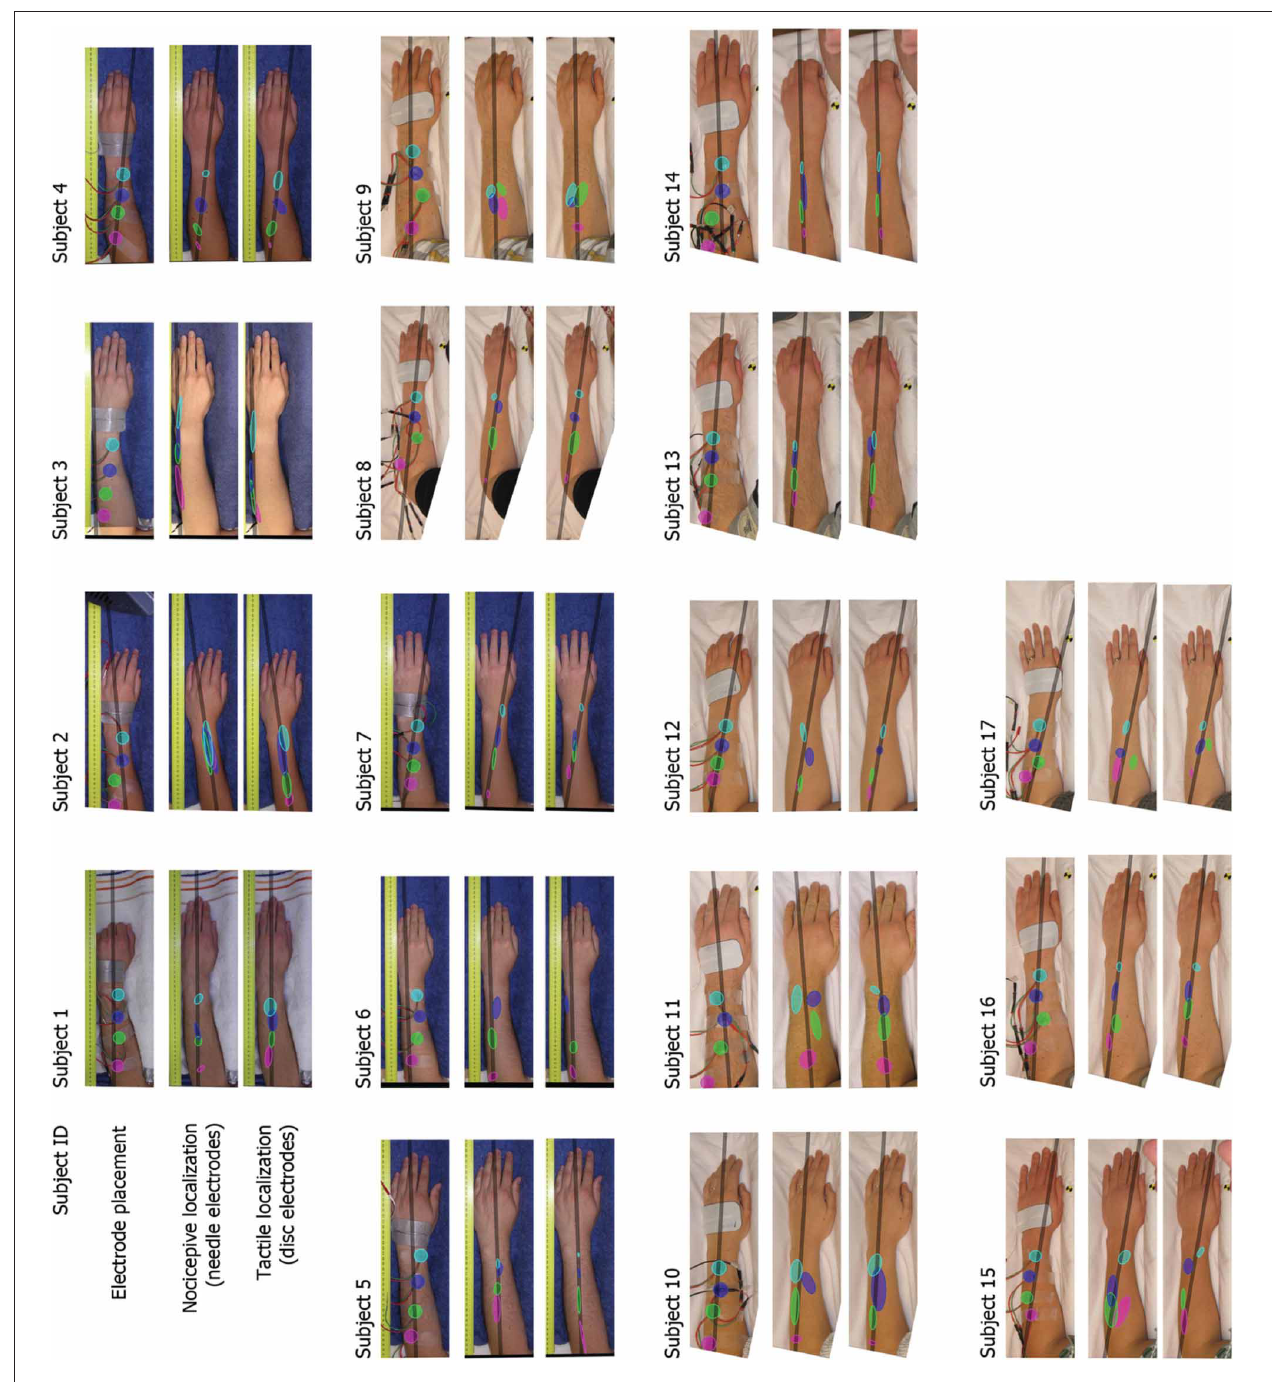
FIGURE 3 | Electrode placements and localizations plotted on the subjects’ arms. The localizations are plotted as means with standard deviations in two directions (the orientation of the ellipses was determined